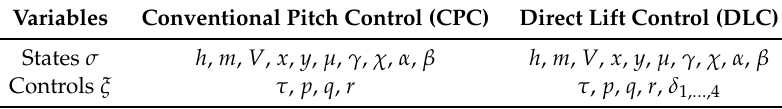
Table 4. Selected grouping of flight parameters into states and